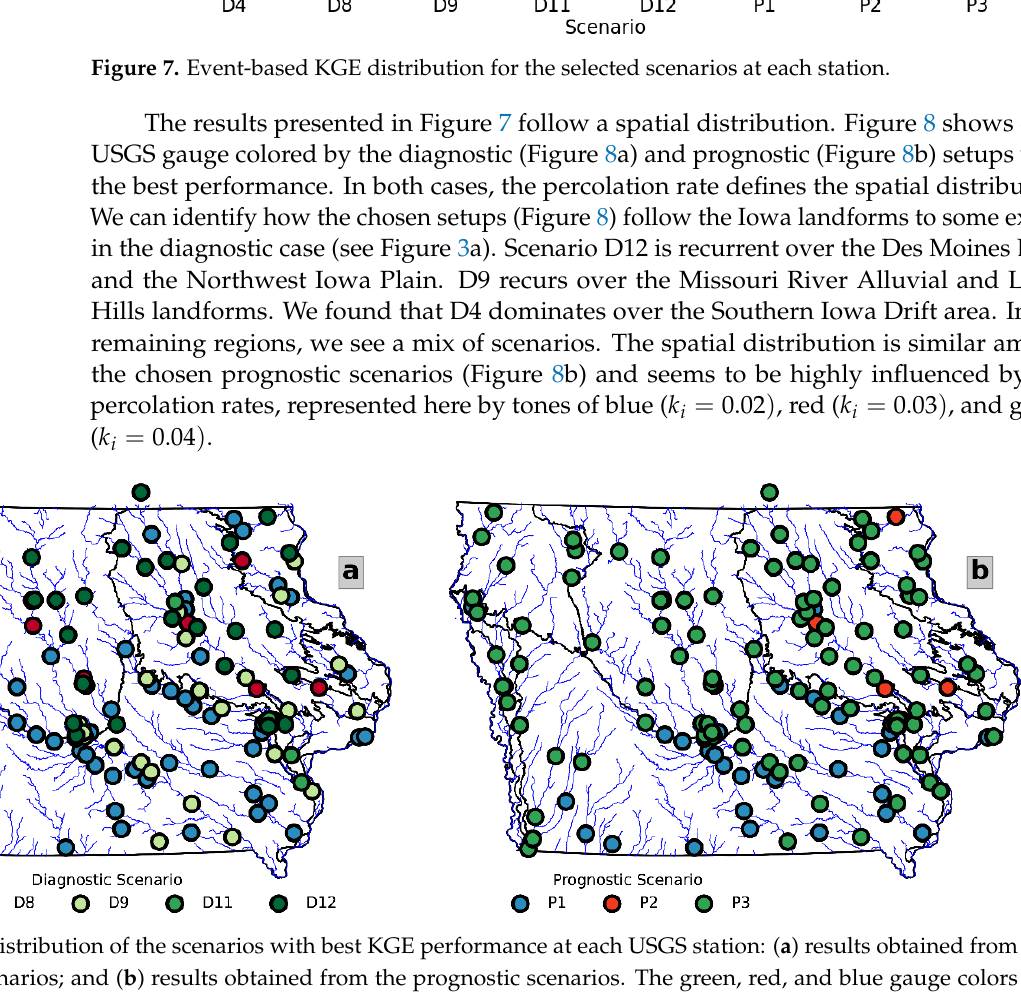
Figure 9. Mean KGE spatial difference of the diagnostic and prognostic scenarios with respect to the linear model: ( a ) diagnostic KGE minus linear model KGE; and ( b ) prognostic KGE minus linear model KGE.